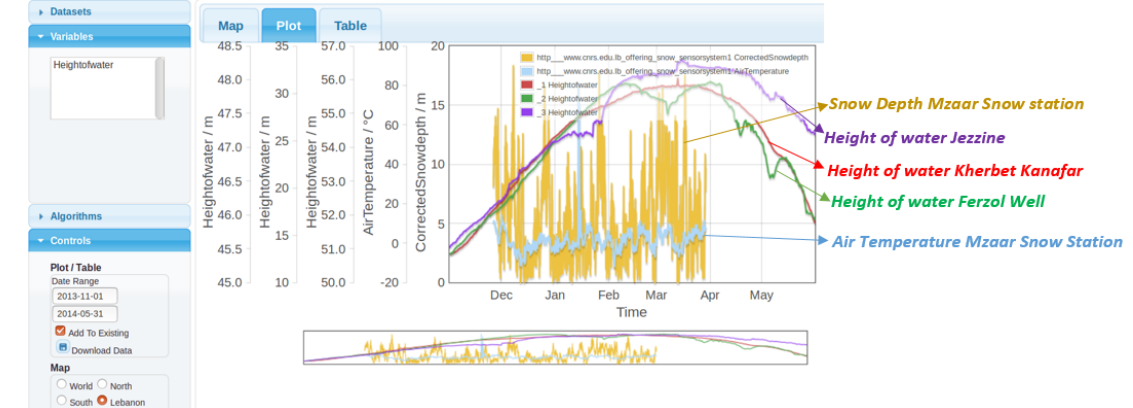
Figure 20. Comparison of snow depth and wells’ water level